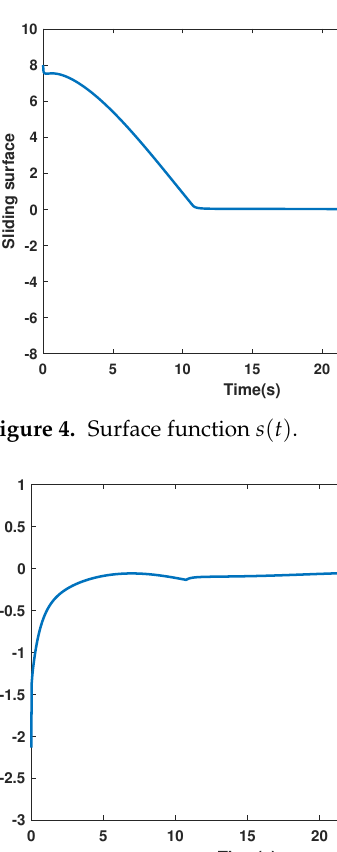
Figure 3. State trajectories of System (3) under the adaptive SMC law.